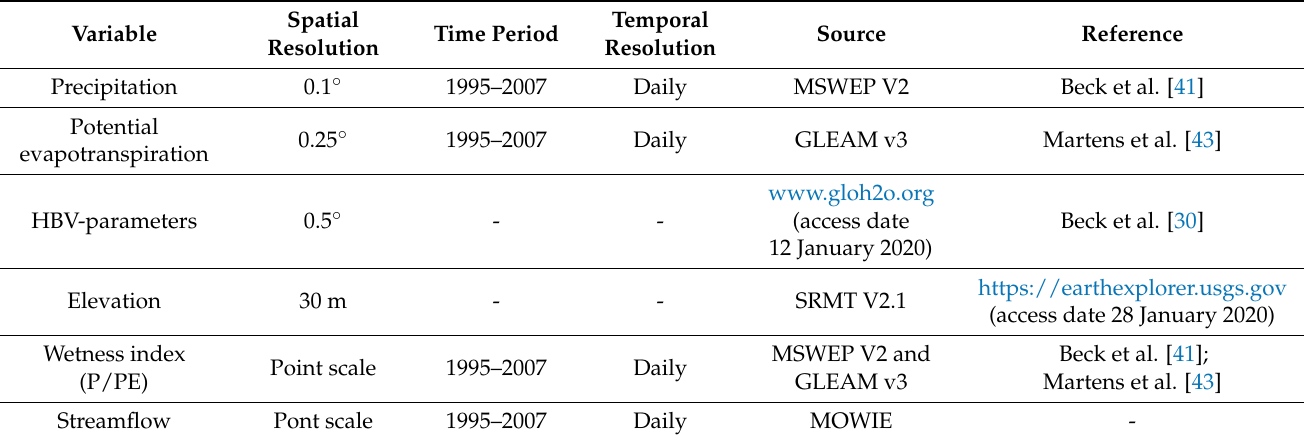
Table 1. Variables showing the climatic and physiographic data and their resolutions and